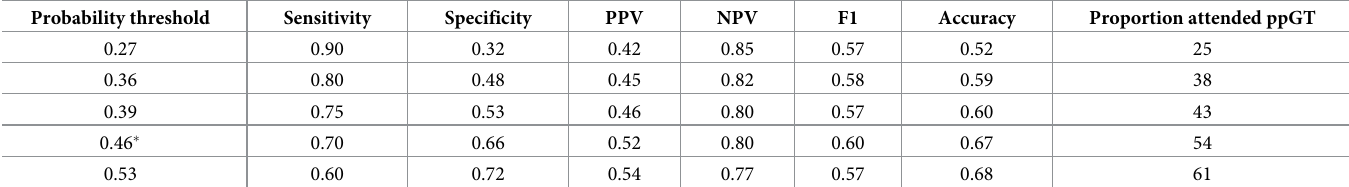
Table 3. Sensitivity and specificity of postpartum glucose attendance by ML algorithm at various probability thresholds. Probability threshold Sensitivity Specificity PPV NPV F1 Accuracy Proportion attended ppGT 0.27 0.90 0.36 0.46 � 0.53 0.60 PPV: Positive predictive value; NPV: Negative predictive value; � Optimal threshold with maximal F1 score that shows sensitivity of 0.70 and specificity of 0.66 to determine the number of GDM women to be focused for postpartum glucose